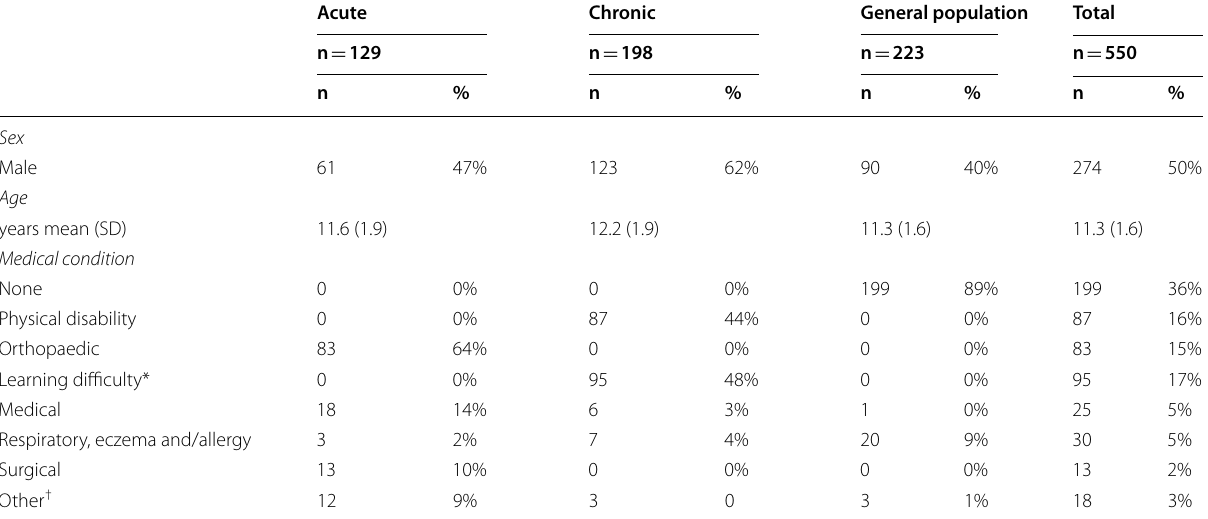
Table 1 Descriptive statistics of the